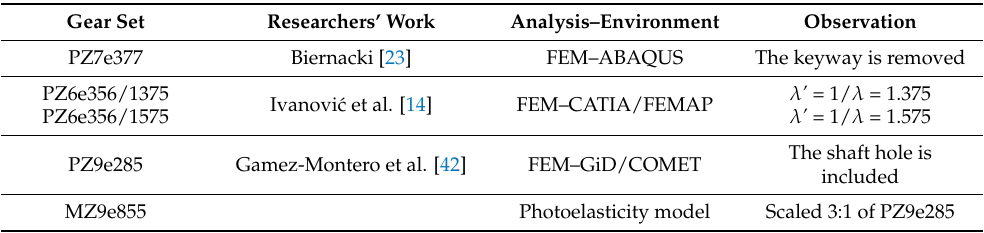
Table 1. Gear sets under study (PZXeYYY, where X is the number of teeth of the outer gear and YYY are the non-decimal eccentricity value).